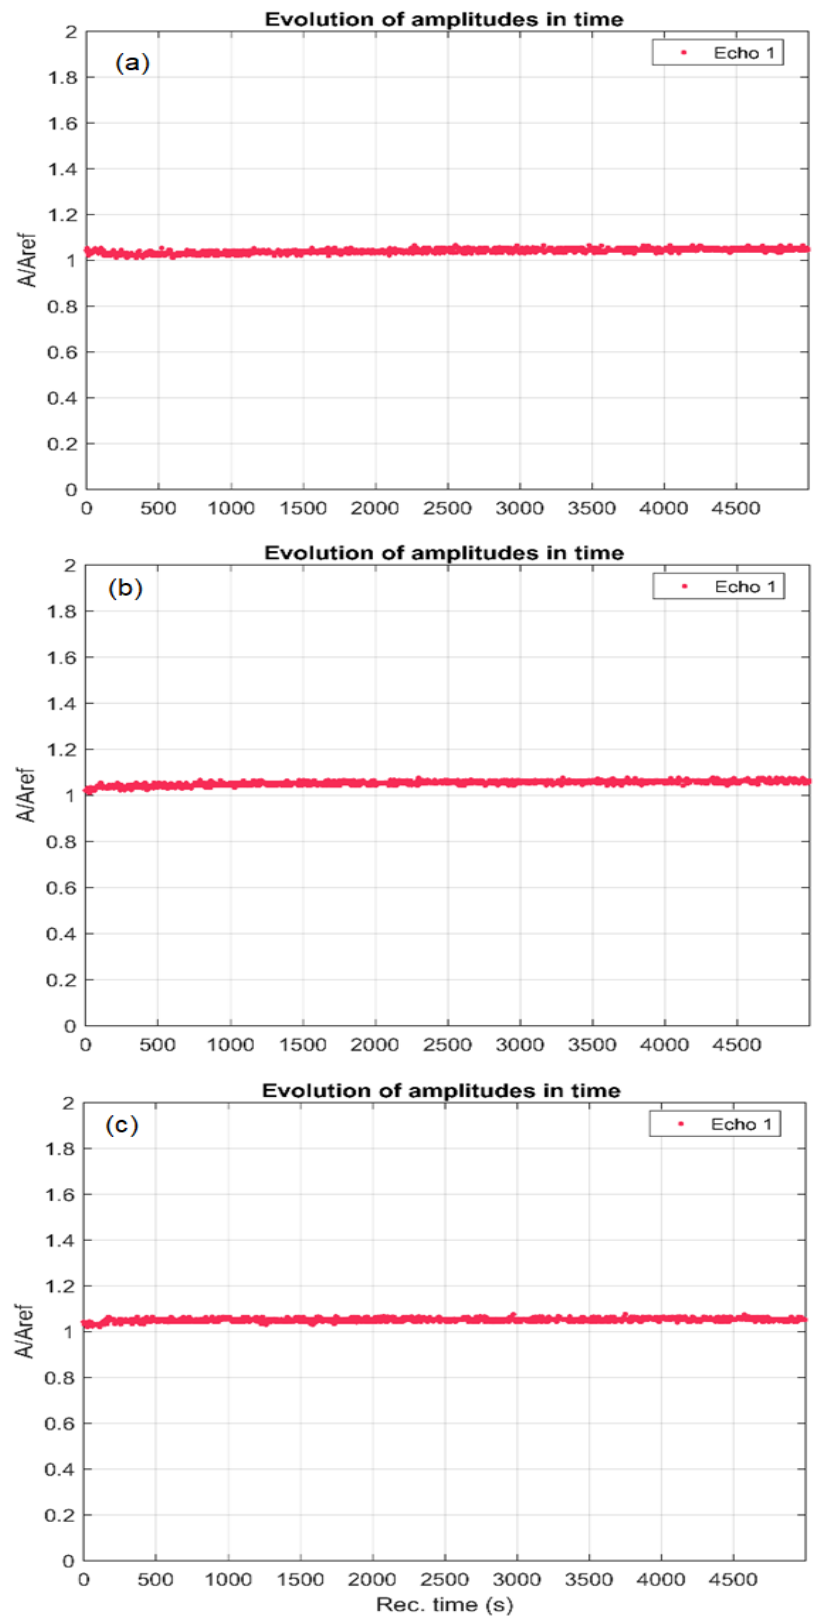
Figure 4. Evolution in time of the signal relative amplitude of samples AgHA ( a ), AgHA-C ( b ) and AgHA-T ( c ).